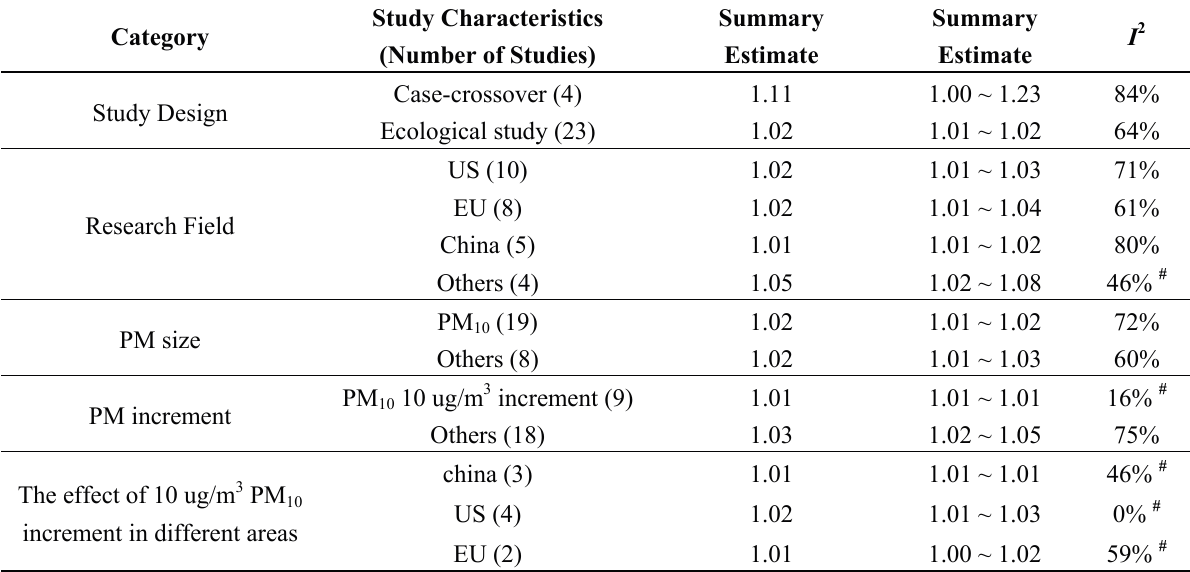
Table 2. Subgroup analysis for the contribution of outdoor air pollution to hospital admission for COPD *